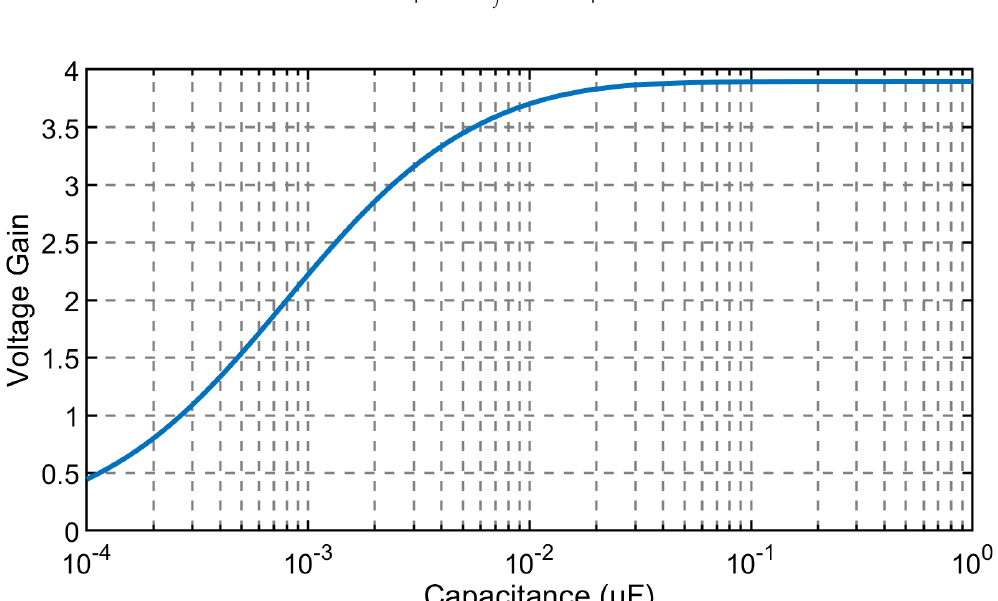
Figure 5. Voltage gain regulations at different flying capacitors